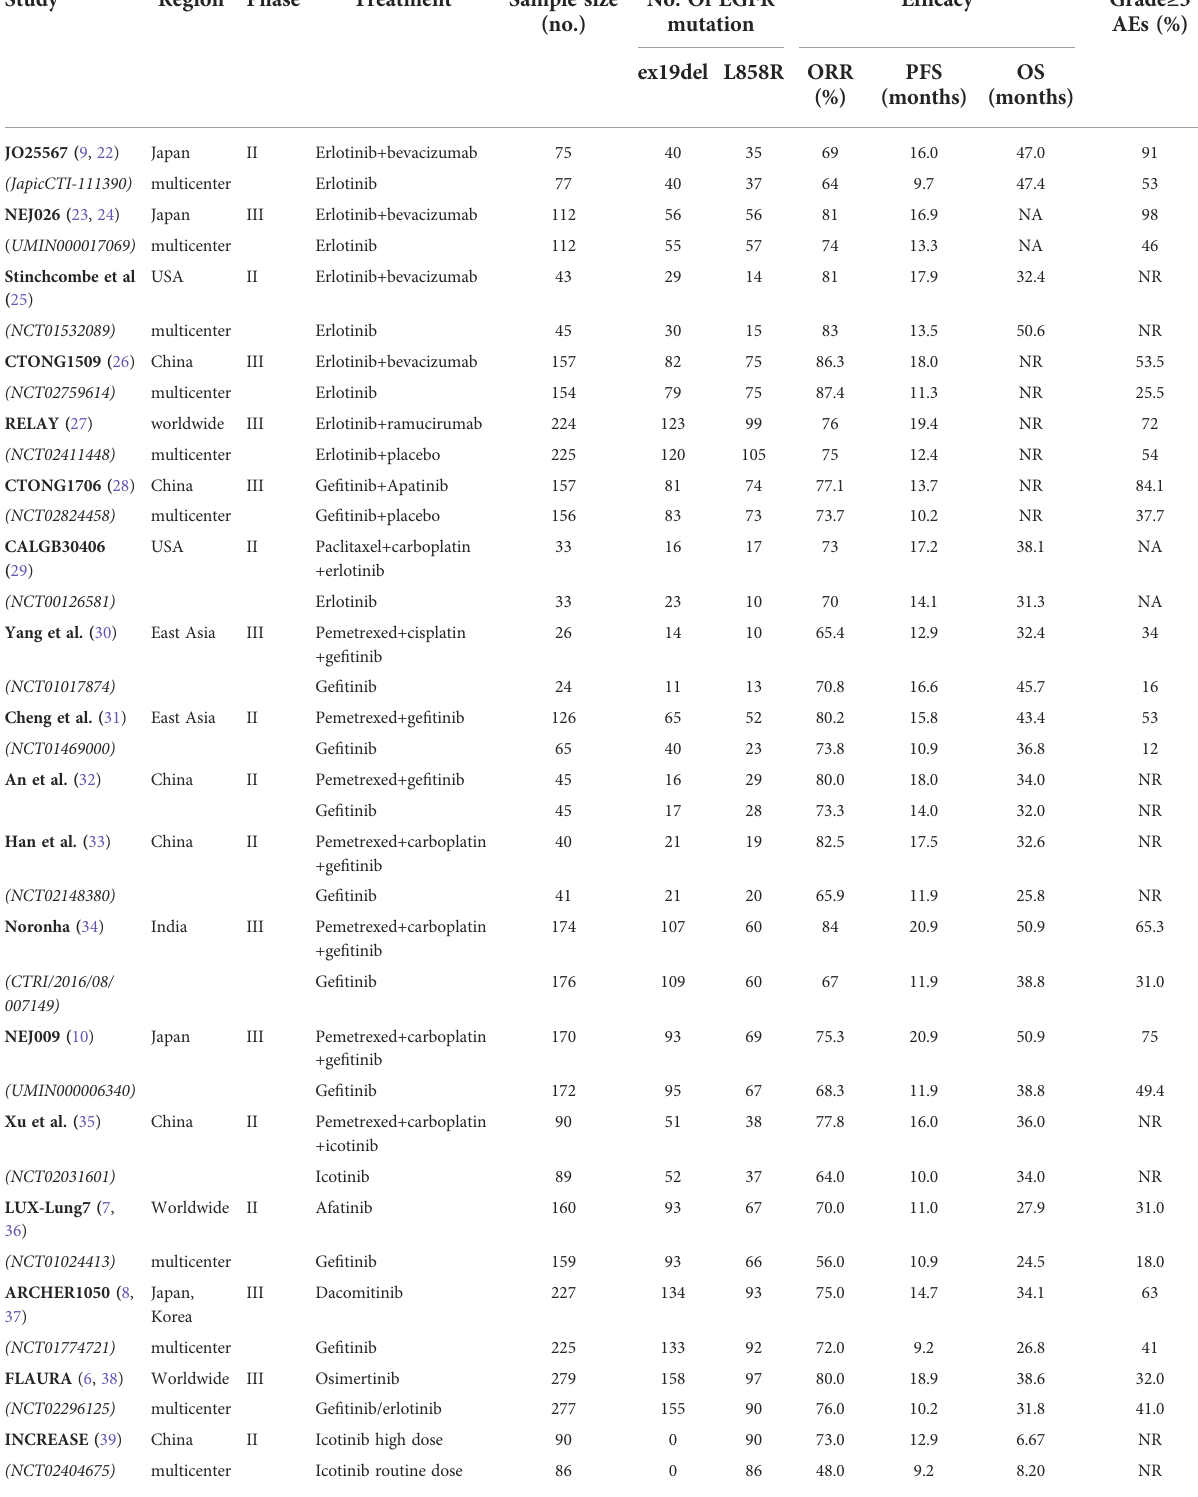
TABLE 1 Characteristics of the included randomized trials in the